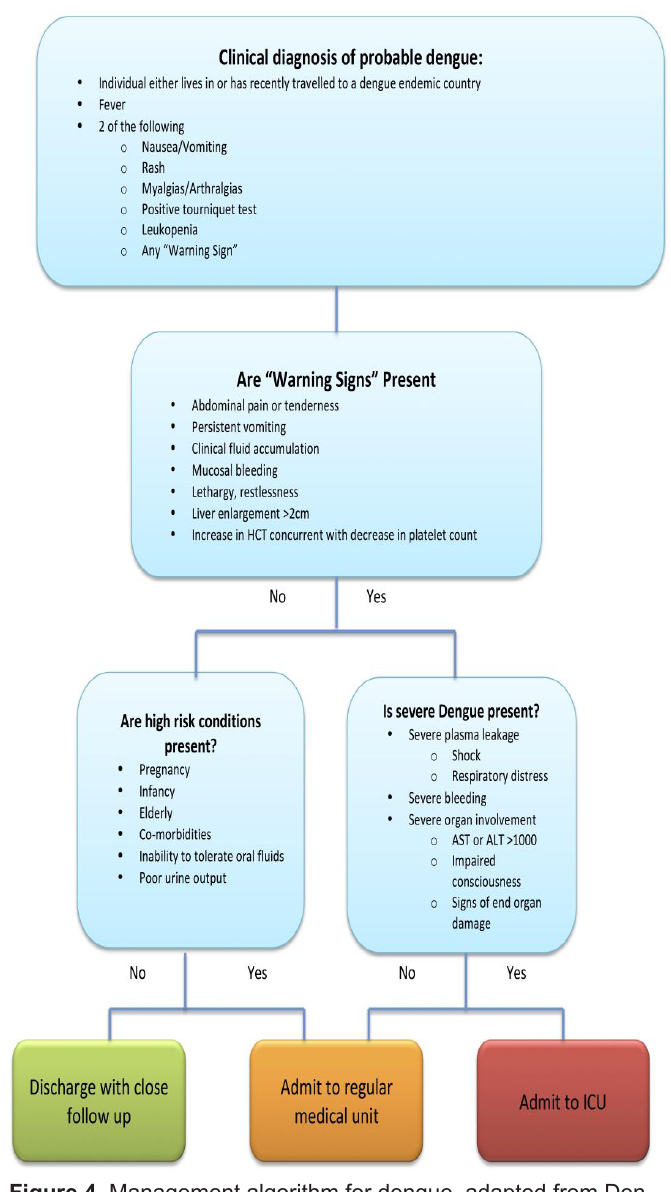
Figure 4. Management algorithm for dengue, adapted from Den- gue Case Management, available at: http://www.cdc.gov/dengue/ resources/DENGUE-clinician-guide_508.pdf.